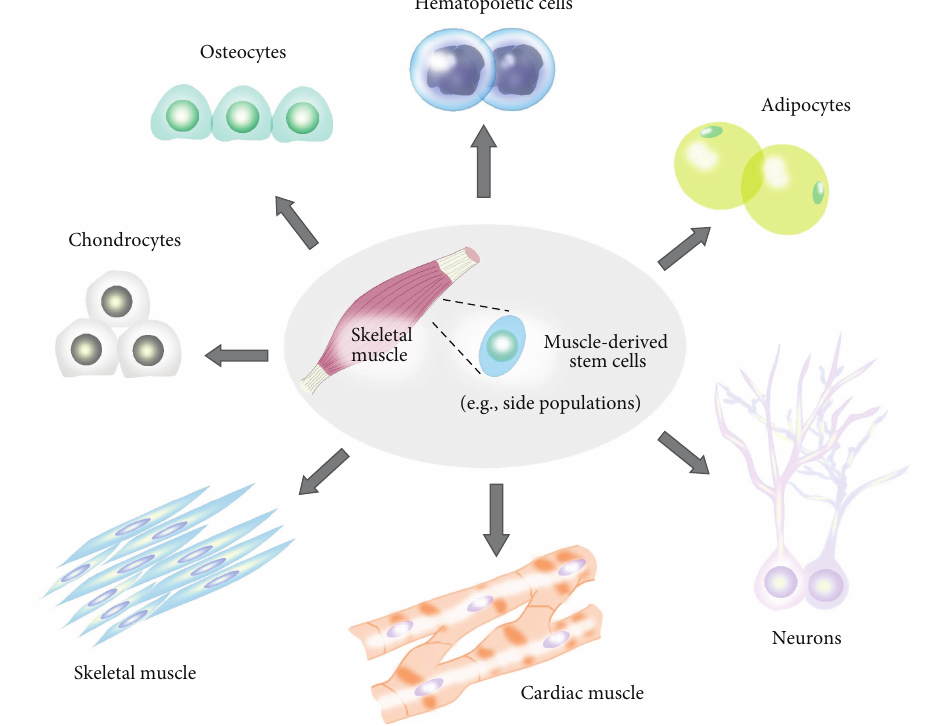
Figure 4: Trans -differentiation of muscle-derived stem cells. Possible trans -differentiation pathways of muscle-derived stem cells. Satellite cells retain a high intrinsic ability for trans -differentiation into multiple lineages (cardiac muscle, skeletal muscle, hematopoietic cells, adipocytes, neurons, chondrocytes, and